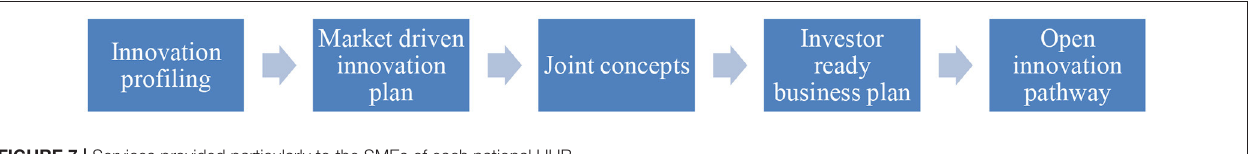
FIGURE 7 | Services provided particularly to the SMEs of each national HUB.